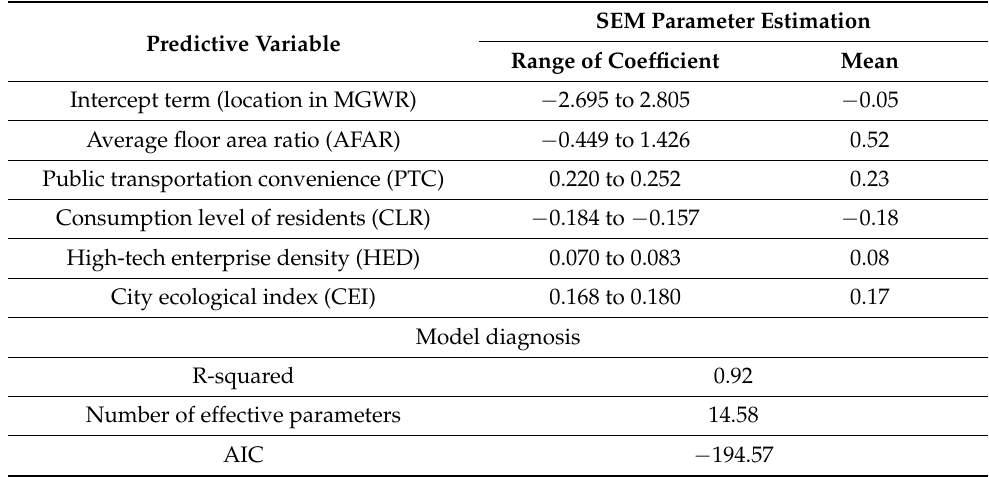
Table 3. Parameters and regression coefficients of the MGWR